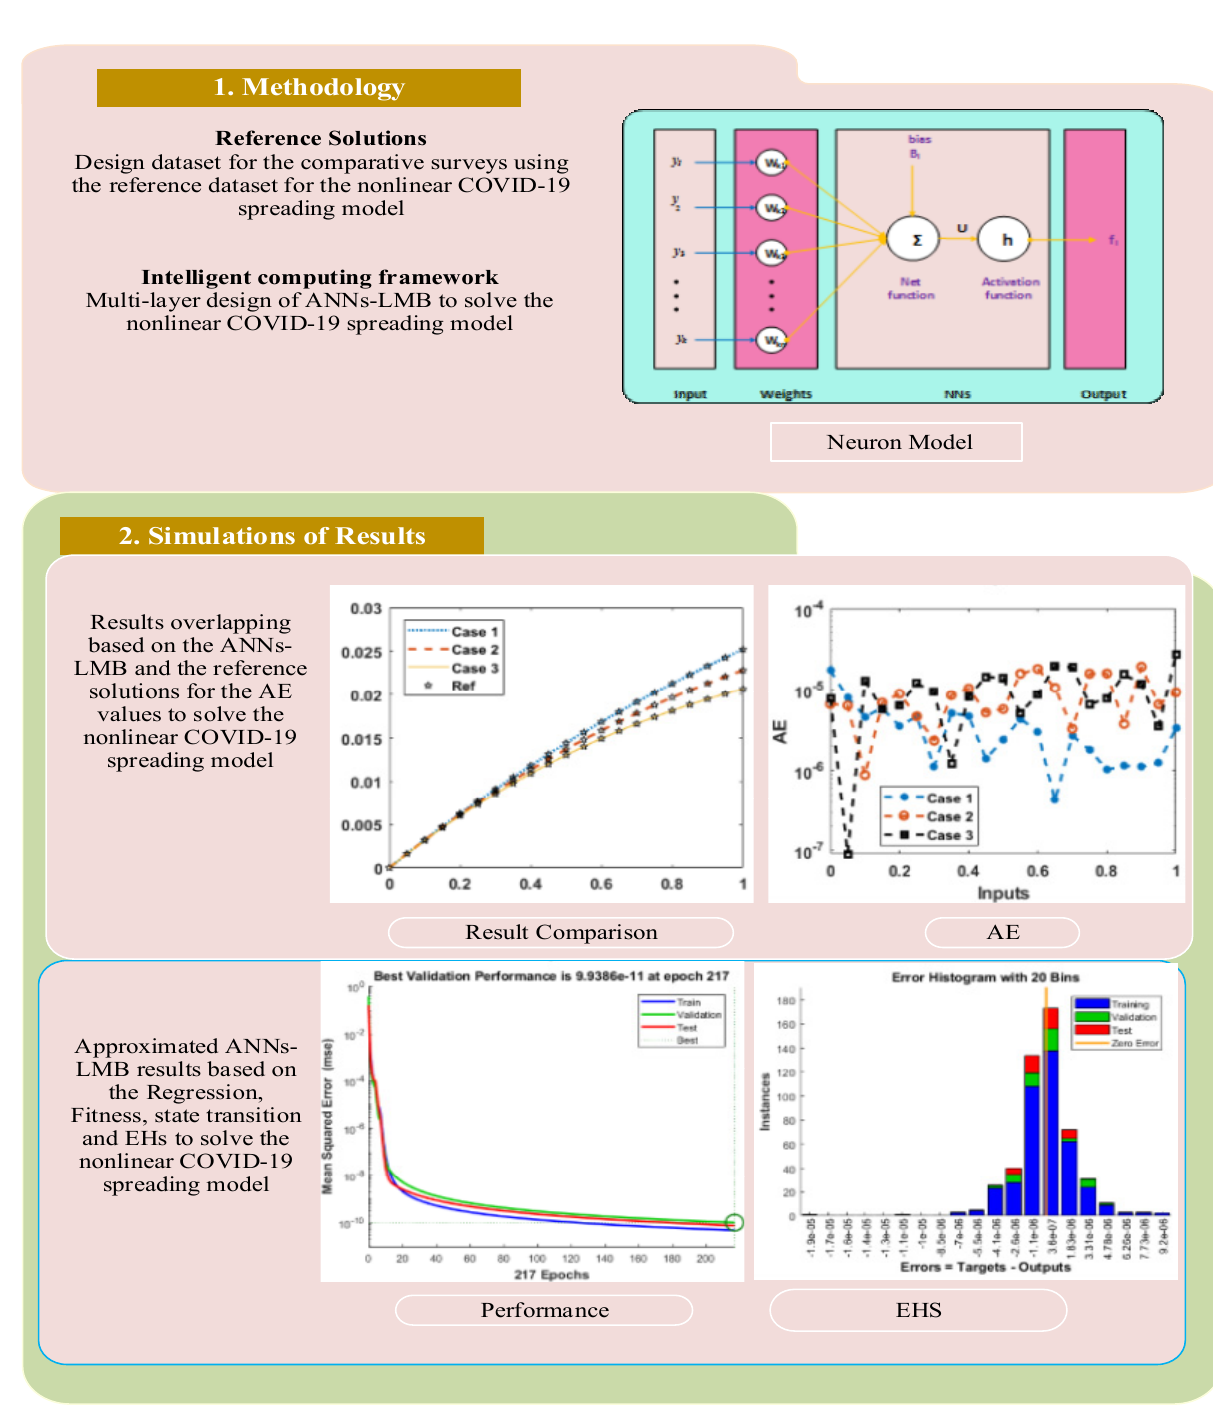
Figure 1. Workflow diagram using the ANNs-LMB to solve the nonlinear COVID-19 spreading model.